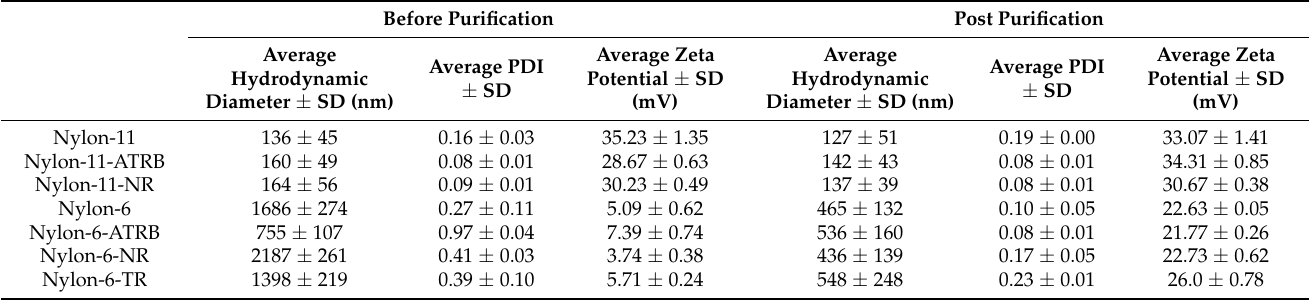
Table 1. Hydrodynamic diameter, PDI, and zeta potential * of nylon NP